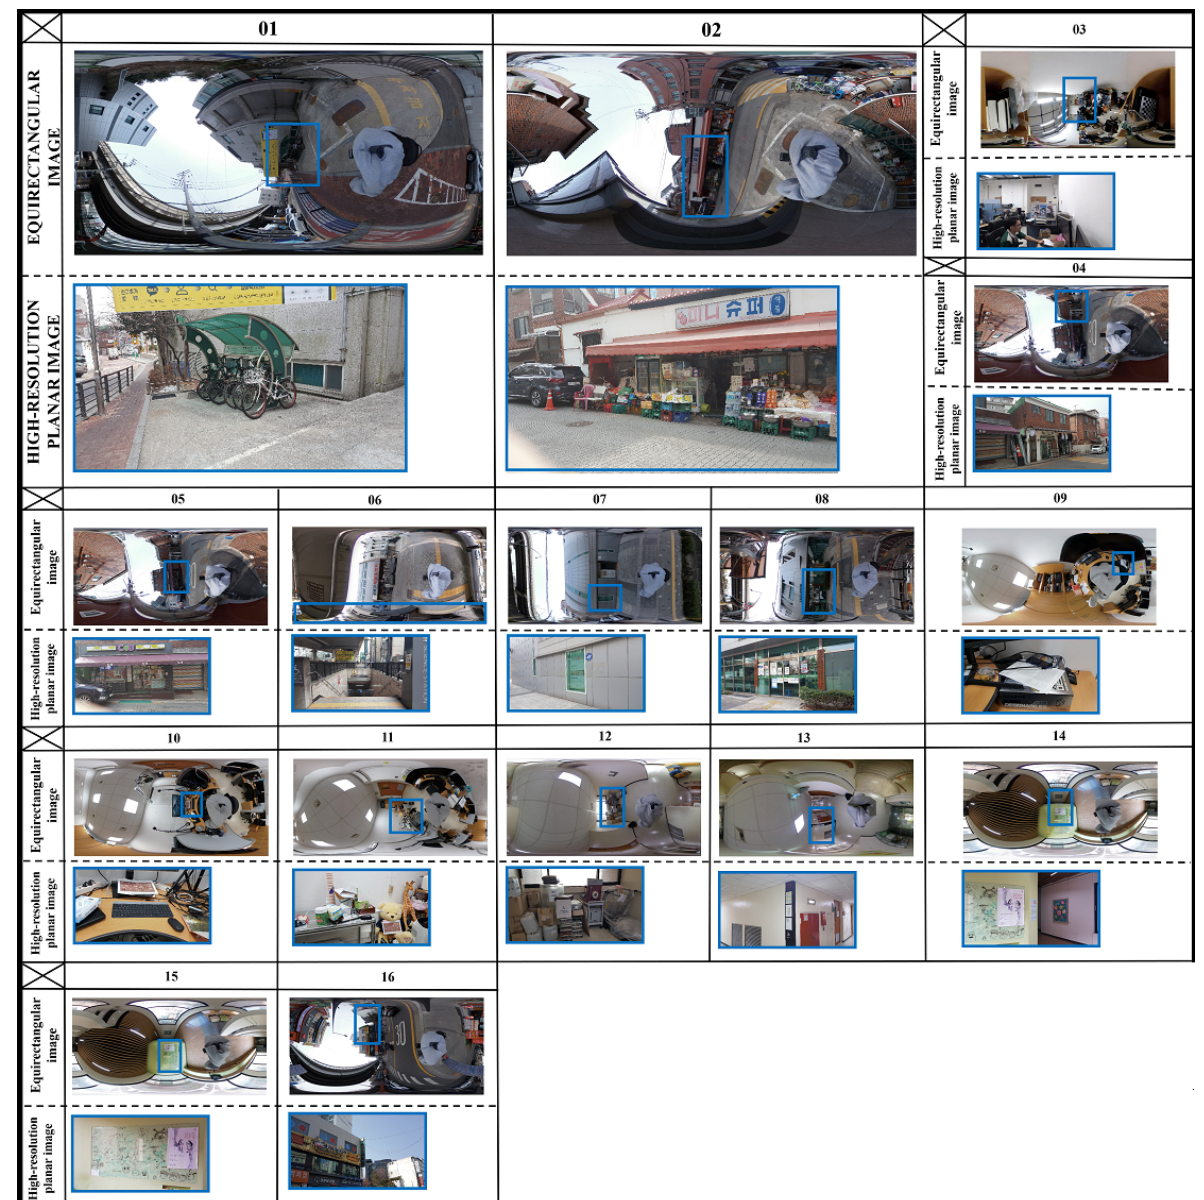
Figure 9. Dataset used for experiments. The blue rectangle for both equirectangular and high-resolution planar image shows the ROI. The equirectangular image (EI) and the high-resolution planar image (HPI) are obtained from 360° and perspective camera,